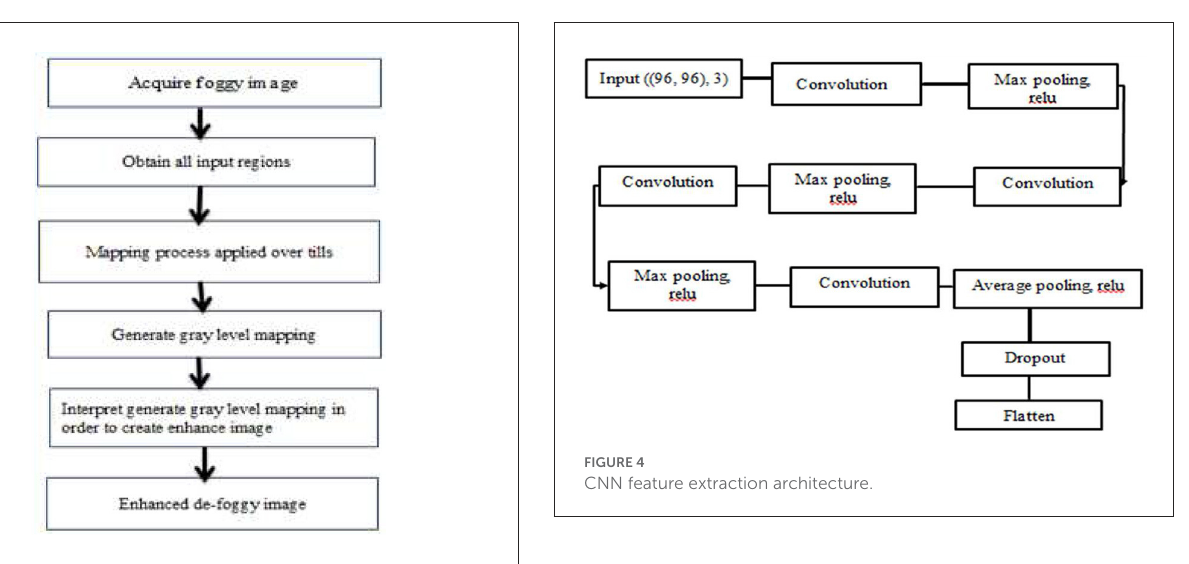
FIGURE3 CLAHE procedure.